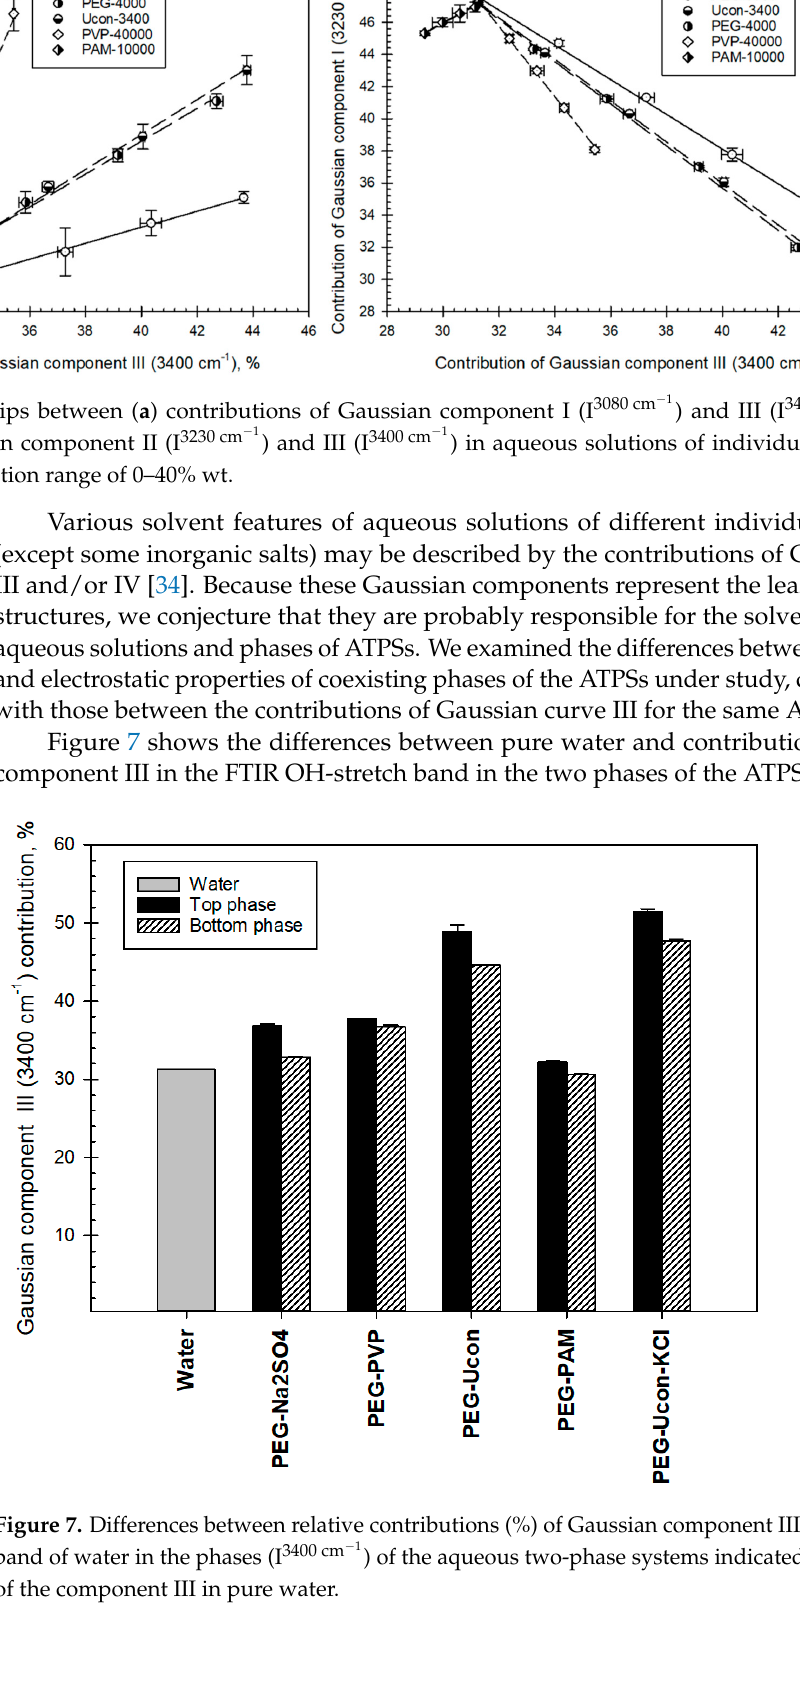
Figure 8. Difference between ( a ) hydrophobic properties (parameter E) of the phases and ( b ) electrostatic properties (param- eter c) as a function of the difference between contributions of Gaussian component III in the OH − stretch band of water in the coexisting phases ( Δ I 3400 cm − 1 ) of the aqueous two-phase systems indicated (parameters E and c as defined in Equation (1)). 5. Conclusions Analysis of the OH-stretch band of water with ATR-FTIR spectroscopy shows that a model based on exactly four Gaussian components positioned at 3080, 3230, 3400, and 3550 cm − 1 is both necessary and sufficient to describe the properties of aqueous media in coexisting phases of ATPSs formed by different combinations of nonionic polymers and a single polymer and inorganic salt. An additional justification for using the chosen positions for each of the four peaks is that free-fitted peak positions for pure water and for the polymer solution with the poly- mer spectrum deweighted are essentially identical, which is not the case for five Gaussian fits.